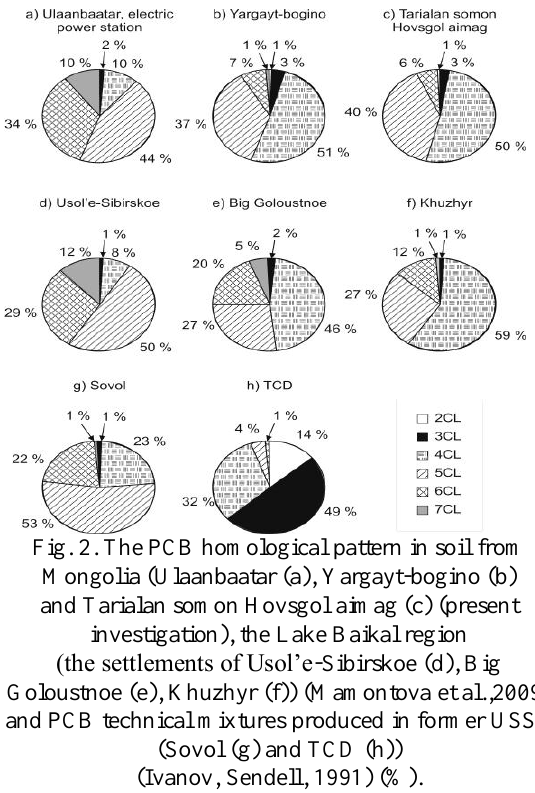
Fig. 2. The PCB homological pattern in soil from Mongolia (Ulaanbaatar (a), Yargayt-bogino (b) and Tarialan somon Hovsgol aimag (c) (present investigation), the Lake Baikal region (the settlements of Usol’e-Sibirskoe (d), Big Goloustnoe (e), Khuzhyr (f)) (Mamontova et al.,2009) and PCB technical mixtures produced in former USSR (Sovol (g) and TCD (h)) (Ivanov, Sendell, 1991) (%).